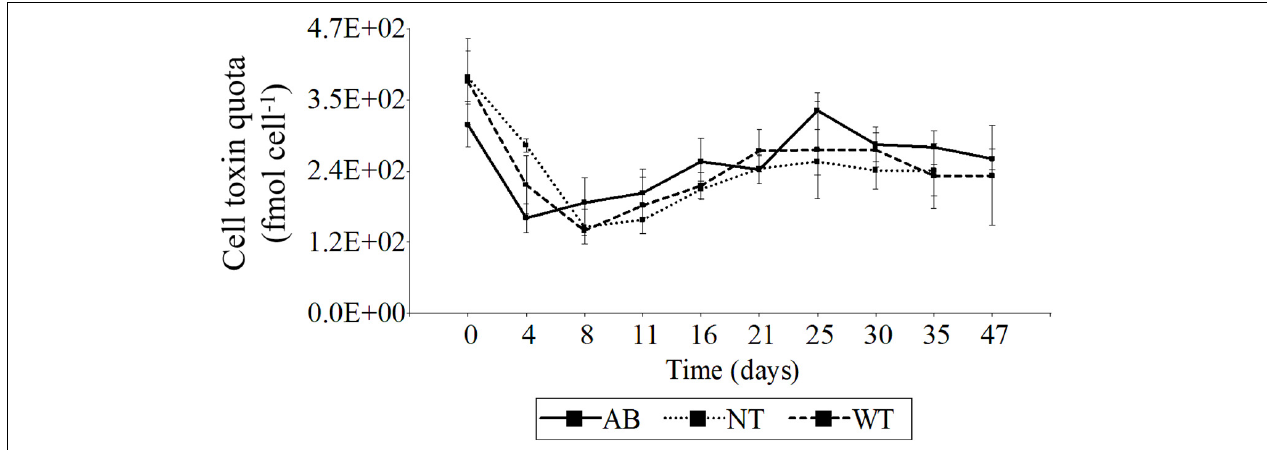
FIGURE 9 | Variation of total DSP toxin cell quota over time-series growth subjected to alternative treatments. Total cell quota (fmol cell - 1 ) calculated as sum of all detectable DSP toxin analogs: OA, OA-D8, DTX1, DTX1-D8, DTX1A, and DTX1a-D8. AB, washed cells plus antibiotics; WT, washed cells; NT, non-treated culture (control). AB, WT, and NT: n = 3 from Day 0 to 35, AB and WT: n = 2 on Day 47. Error bars indicate mean ± standard deviation (SD) of replicate